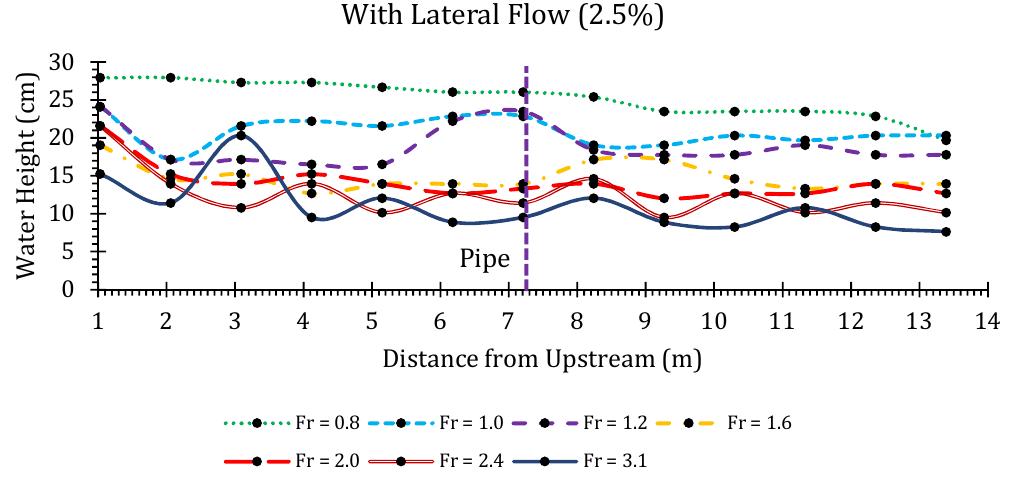
Figure 8. Water heights in the wide channel, with 2.5% lateral flow.